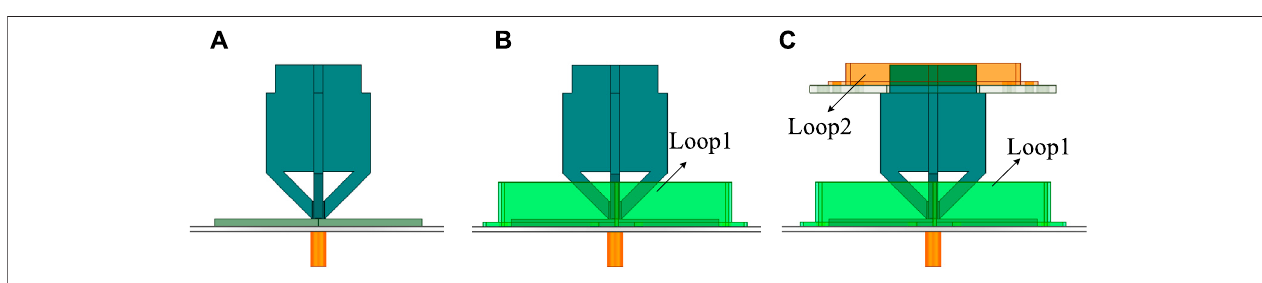
FIGURE 4 | Evolution steps of the proposed antenna: (A) Ant1, (B) Ant2, (C) Ant3.